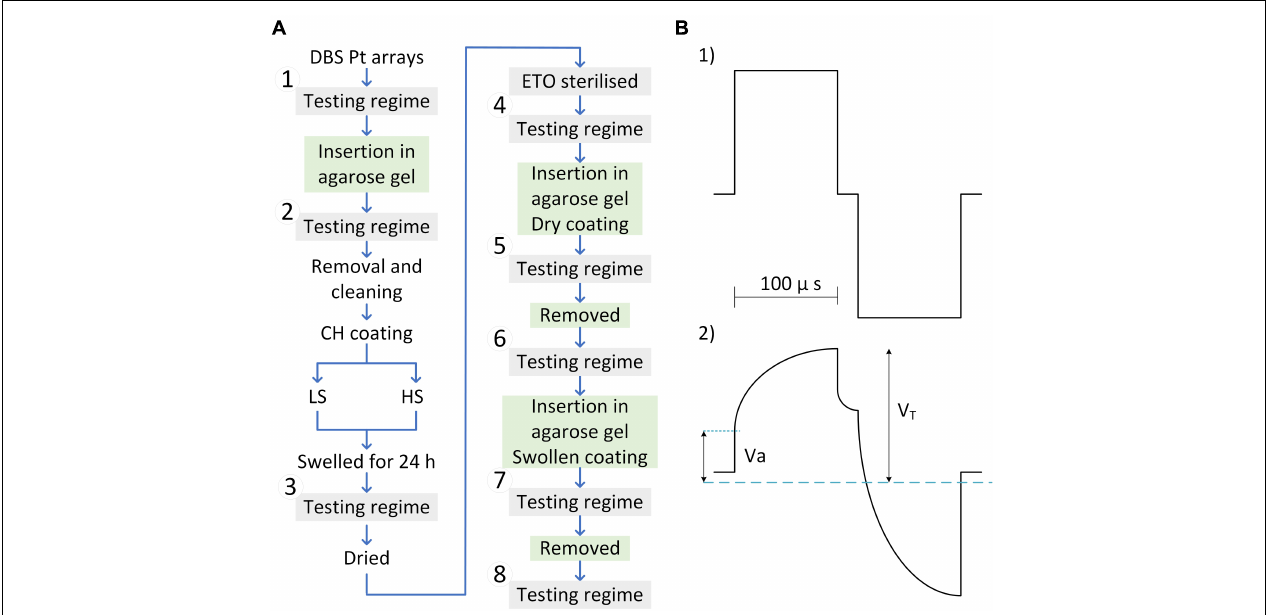
FIGURE 2 | (A) Flow chart of tests and treatment performed on DBS arrays. Four arrays were tested in total, two coated with the low swelling formulation (LS), and two coated with the high swelling formulation (HS). The electrochemical performance of uncoated DBS arrays was assessed before and after insertion into the agarose gel to generate baseline Pt Data (1–2). Arrays were then CH-coated and swollen to provide baseline CH properties (3). Following ethylene oxide sterilisation (4) the in-agarose gel testing consisted of assessing changes in electrochemical properties following insertion of dry and swollen CH-coated electrodes in agarose gels (5 and 7) compared to baseline (3). Arrays were removed from the agarose gel and assessed in PBS (6 and 8). (B) Biphasic electrode pulse (top) and voltage transient of Pt in reference to Ag/AgCl electrode